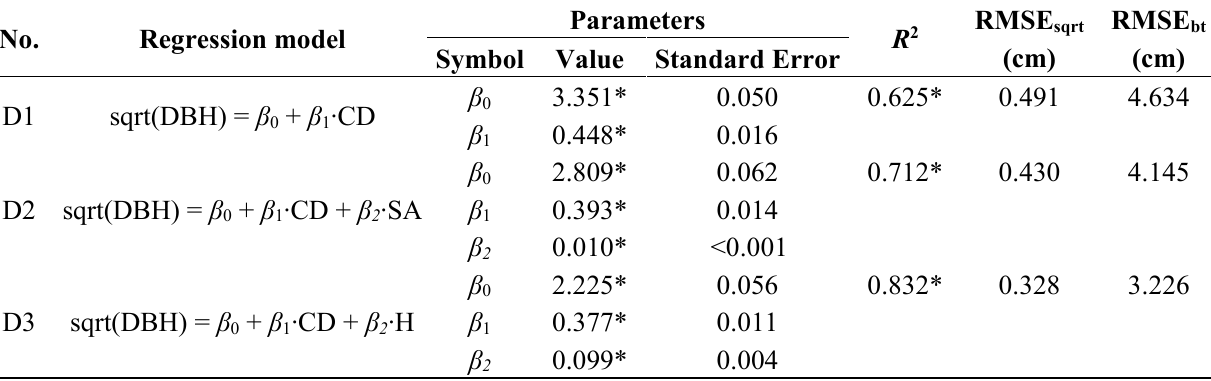
Table 3. Description and evaluation statistics for five selected black pine diameter at breast height (DBH)